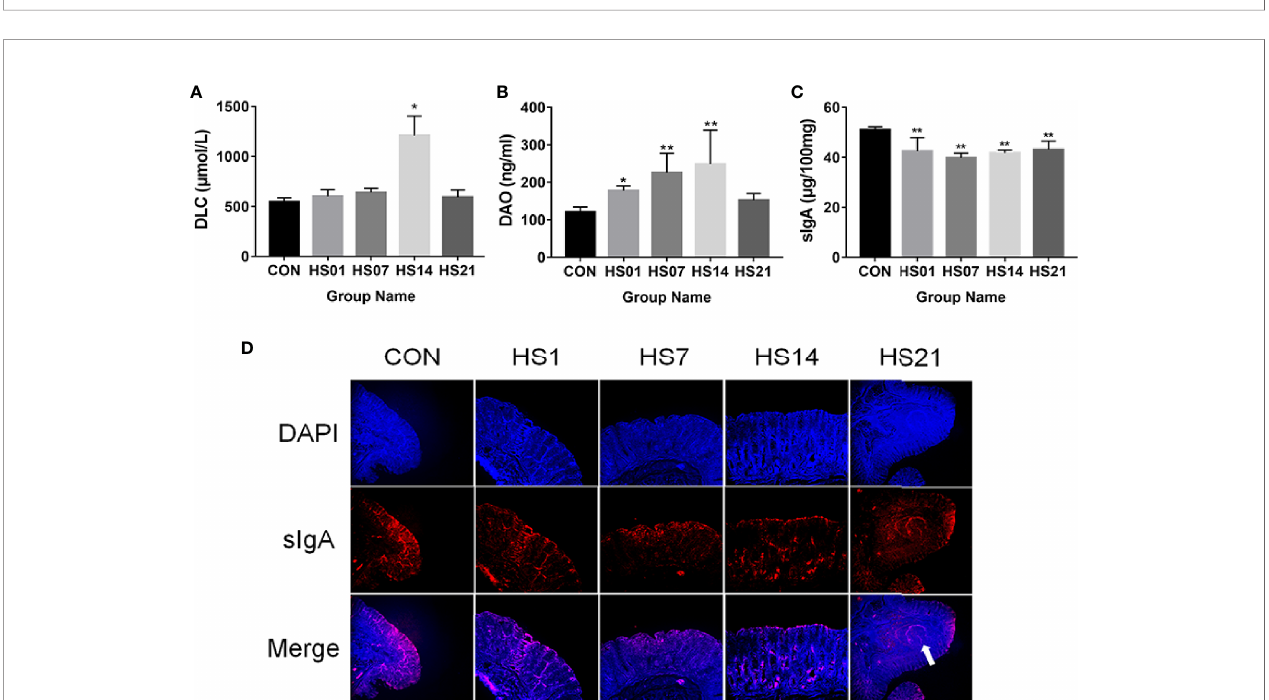
FIGURE 3 | Effect of HS on the biochemical markers of serum and colon. CON indicates no heat stress group of day 1, HS1, 7, 14, 21 indicate heat stress day 1, 7, 14, and 21 groups respectively, n = 6; “ * ” indicates p < 0.05, and “ ** ” indicates p < 0.01. (A) serum D-lactic acid; (B) serum diamine oxidase; (C) sIgA of colonic content; (D) distribution of sIgA in colon.